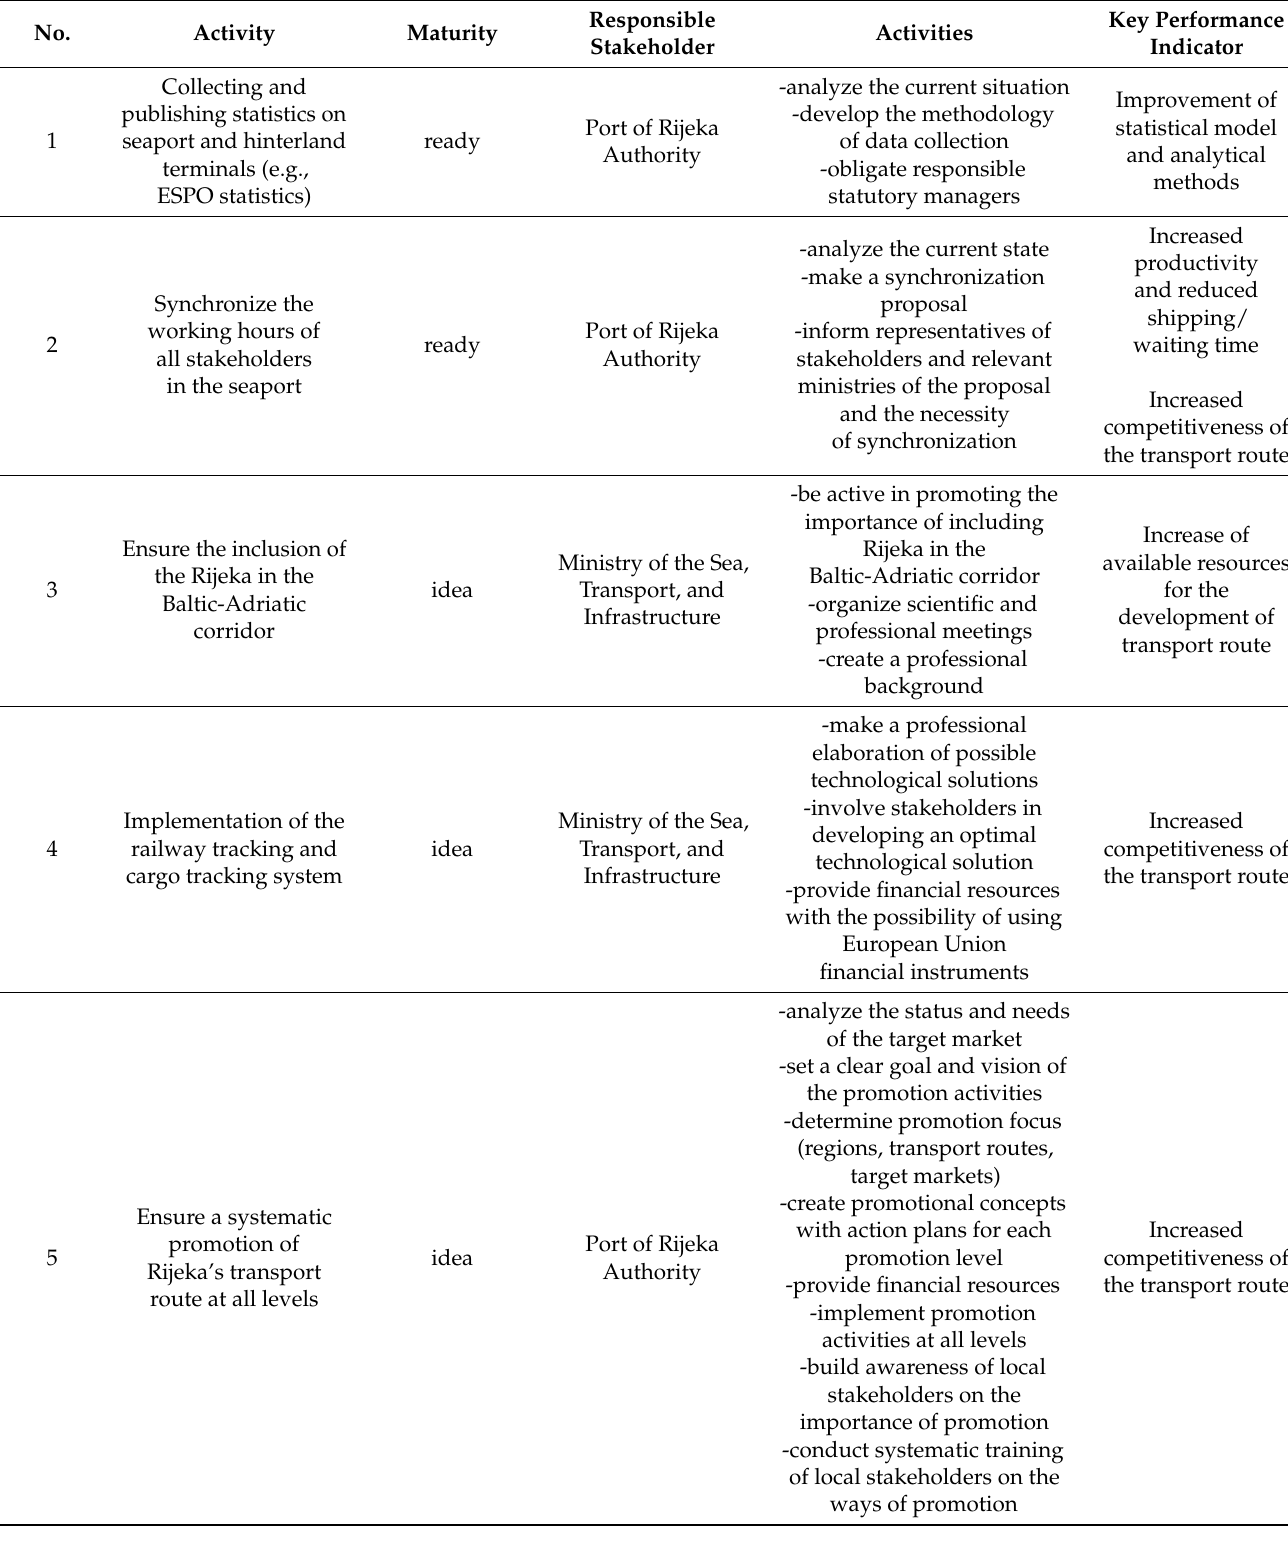
Table 3. Proposed Measures to Improve the Competitiveness of the Port of